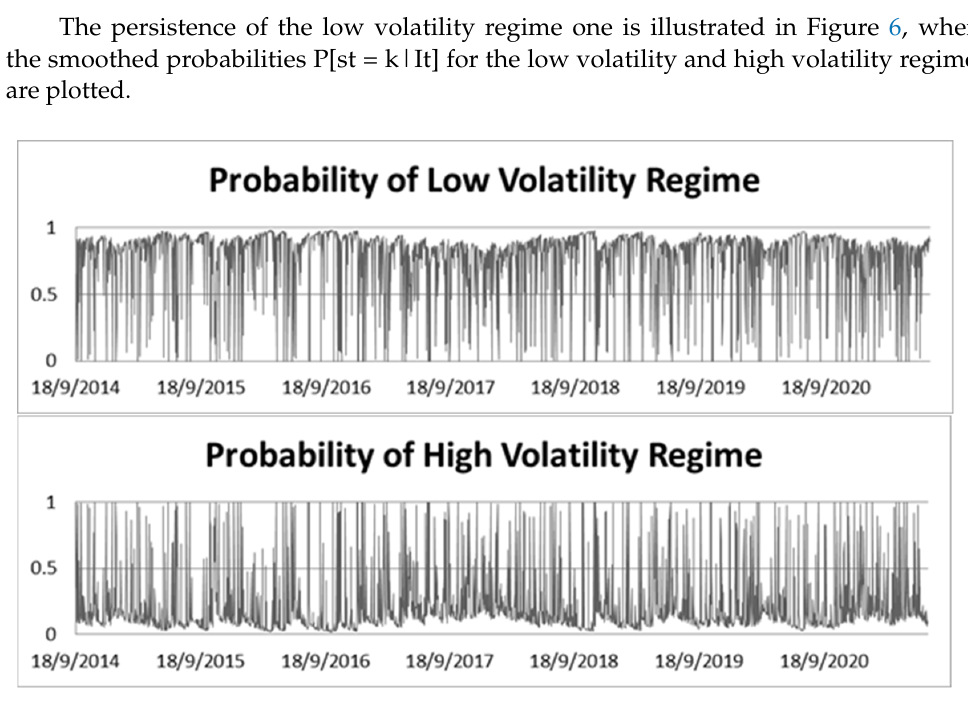
Table 10. p -values for the CC test and DQ test for the one-day ahead 5% VaR.